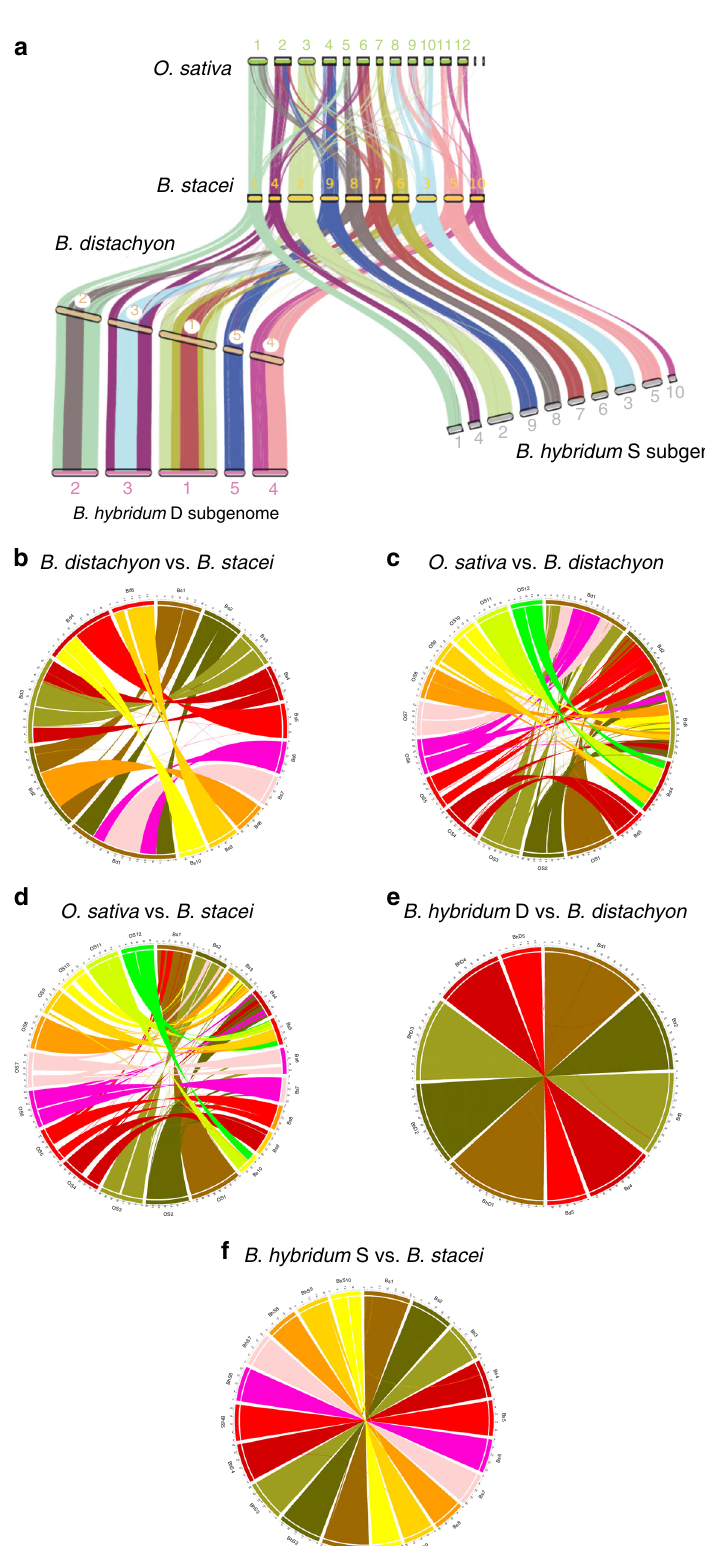
Fig. 2 Syntenic relationships. a Synteny between chromosomes, represented by colors, indicates that the B. distachyon Bd21 chromosomes were derived from an ancestor similar to B. stacei ABR114 through a series of nested insertions of whole chromosomes into centromeric regions in Bd1, Bd2, and Bd3, fusion of two chromosomes to Bd4, and full collinearity of one chromosome with Bd5. Note that the genomes of B. distachyon Bd21 and B. stacei ABR114 are essentially 100% collinear with the S and D subgenomes of B. hybridum ABR113, respectively. b – f Circos plots showing syntenic relationships between the above-mentioned genomes and subgenomes. Note the high conservation in synteny between B. distachyon Bd21 and B. hybridum ABR113 D subgenome ( e ) and between B. stacei ABR114 and B. hybridum ABR113 S subgenome ( f